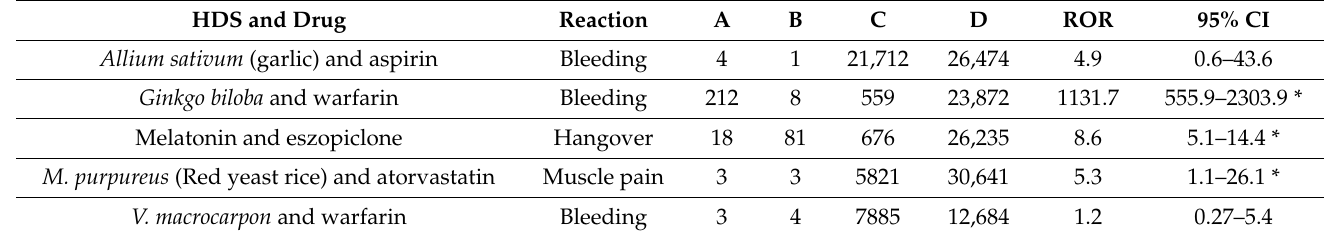
Table 4. Disproportionality analysis of FAERS data. A: Number of reactions of interest in those exposed to herb of interest; B: Number of other types of reactions reported for herb of interest; C: Number of reactions of interest reported without herb of interest; D: Number of other types of reactions reported without herb of interest. ROR reporting odds ratio = AD/BC; CI confidence interval; * statistically significant at alpha =